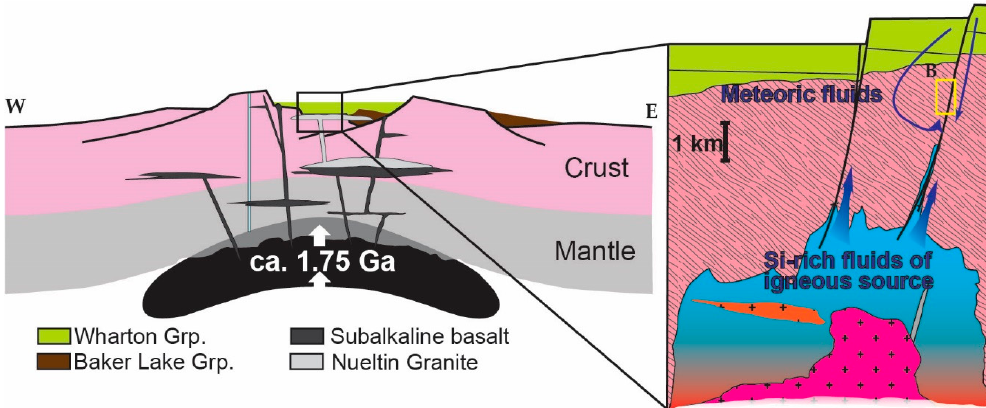
Figure 10. Cross-section after Peterson et al. [46] and zoom in the zone of formation of the QB.